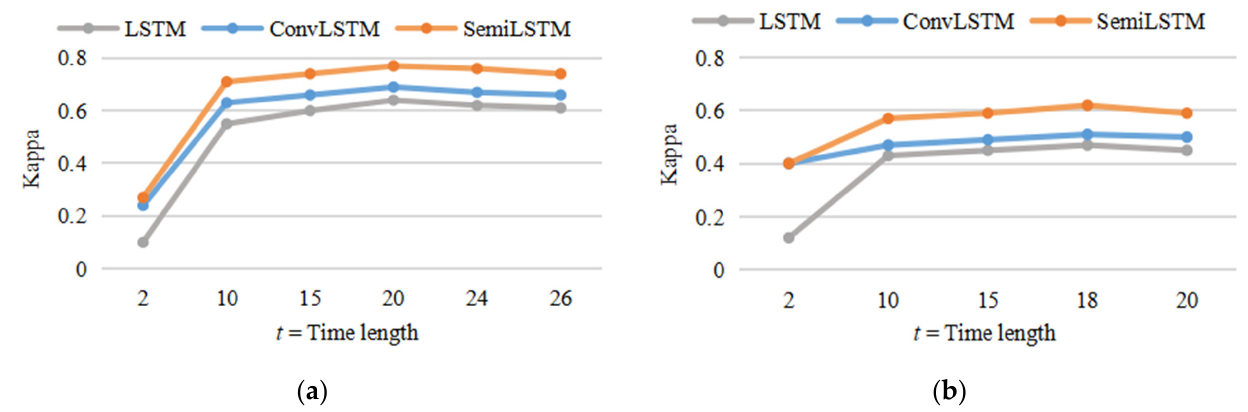
Figure 8. The results (Kappa) of comparative experiments with various length of time series input in Jiamusi and Kunshan data set. ( a ) Jiamusi time series data set; ( b ) Kunshan time series data set.